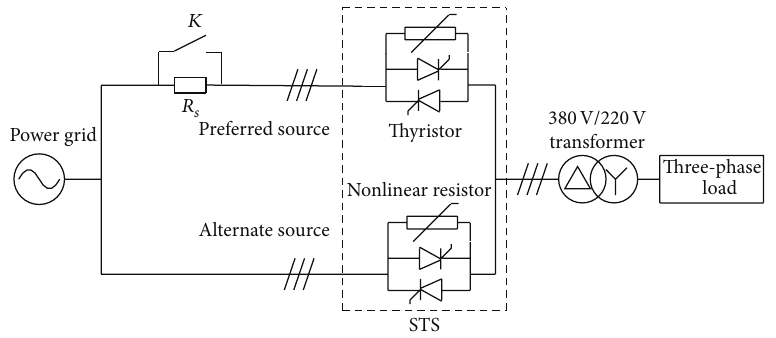
Figure 13: The circuit of the laboratory experiment.